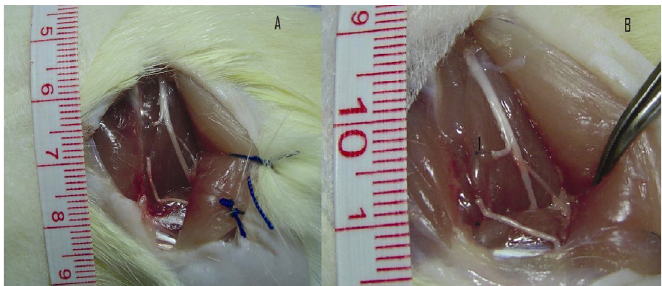
FIGURE 2 - Trans-operatory picture of a group B animal: repair-sham operation. A) Sectioned fibular nerve. B) Detail showing the proximal stump in the fibular nerve (1) and distal stump ( * ) not submitted to repair